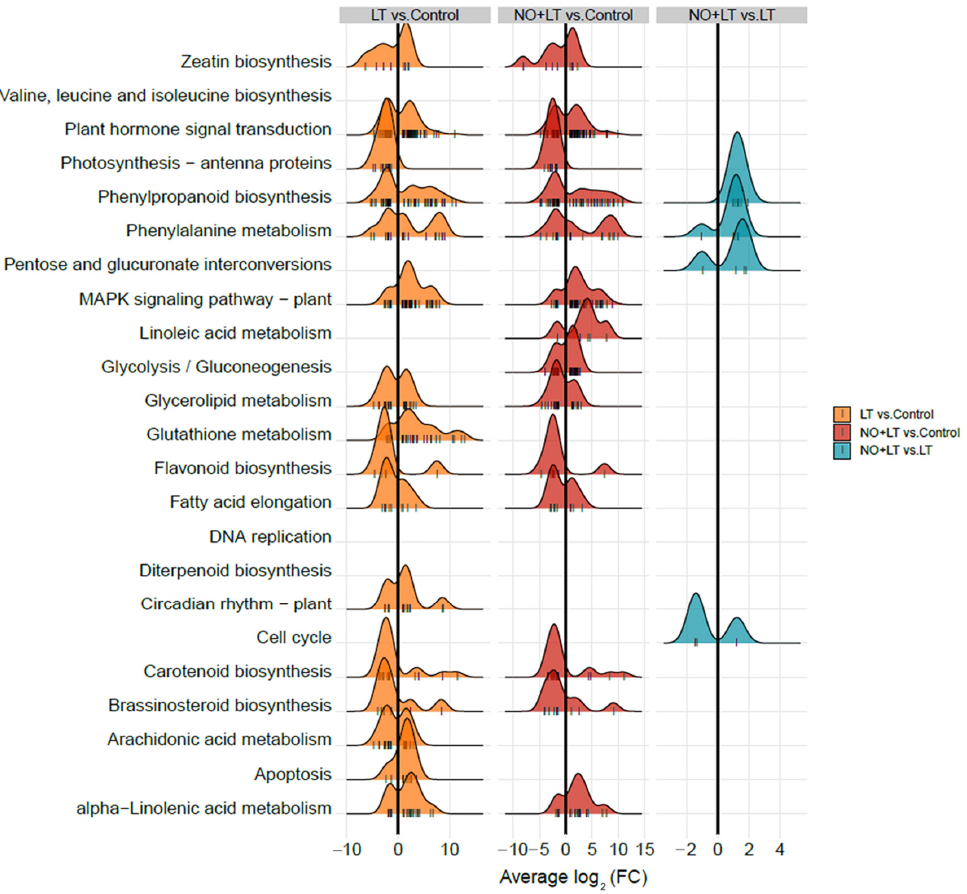
Figure 4. Ridgeline plot of Kyoto Encyclopedia of Genes and Genomes (KEGG) enrichment analysis. The X-axis represents the average of the gene’s log 2 (fold change). Greater than zero is the up-regulated gene, and less than zero is the down-regulated gene. Ridge height reflects the number of DEGs enriched in this pathway.